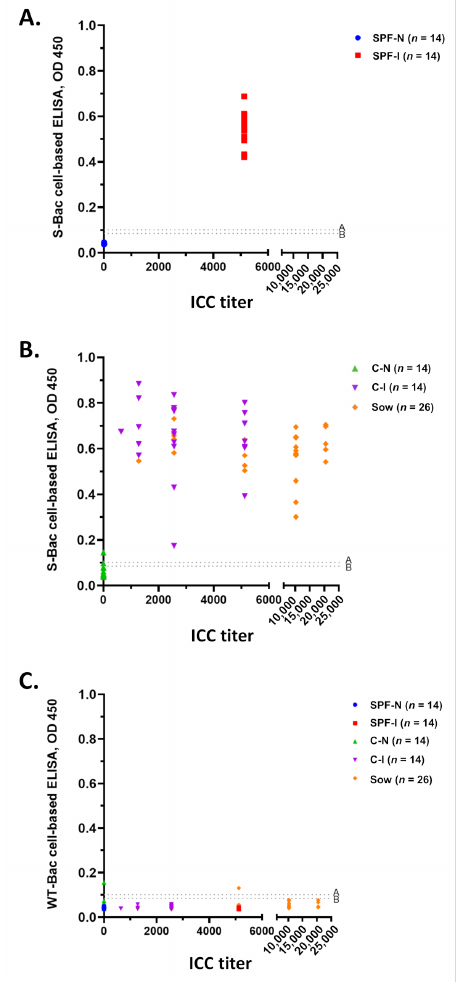
Figure 6. Serum detection using S-Bac-infected cell-based ELISA and its comparison to ICC titer. ( A ) Distribution of ICC titer and S-Bac-infected cell-based ELISA for SPF piglet sera, SPF-N and SPF-I. ( B ) Distribution of ICC titer and S-Bac-infected cell-based ELISA for piglet (C-N and C-I) and sow sera collected from conventional farms. ( C ) Comparison of ICC titer and WT-Bac-infected cell-based ELISA for all pig sera. ICC titers of each serum sample are presented according to serial dilution. Serum samples with ICC titer less than 160 are denoted as 0. Mean OD values represent the results of S-Bac-infected cell-based ELISA. The cutoff values were determined using the mean value for negative samples plus two or three standard deviations (SD). The dotted line A represents the cutoff value 0.1 (mean +3 SD) and dotted line B represents the cutoff value 0.09 (mean +2 SD). SPF-N: specific pathogen-free PEDV-negative piglets; SPF-I: PEDV-inoculated SPF piglets; C-N: conventional farm-based PEDV-negative piglets; C-I: PEDV-inoculated conventional piglets; Sow: farm-based sows fed with PEDV-positive intestinal